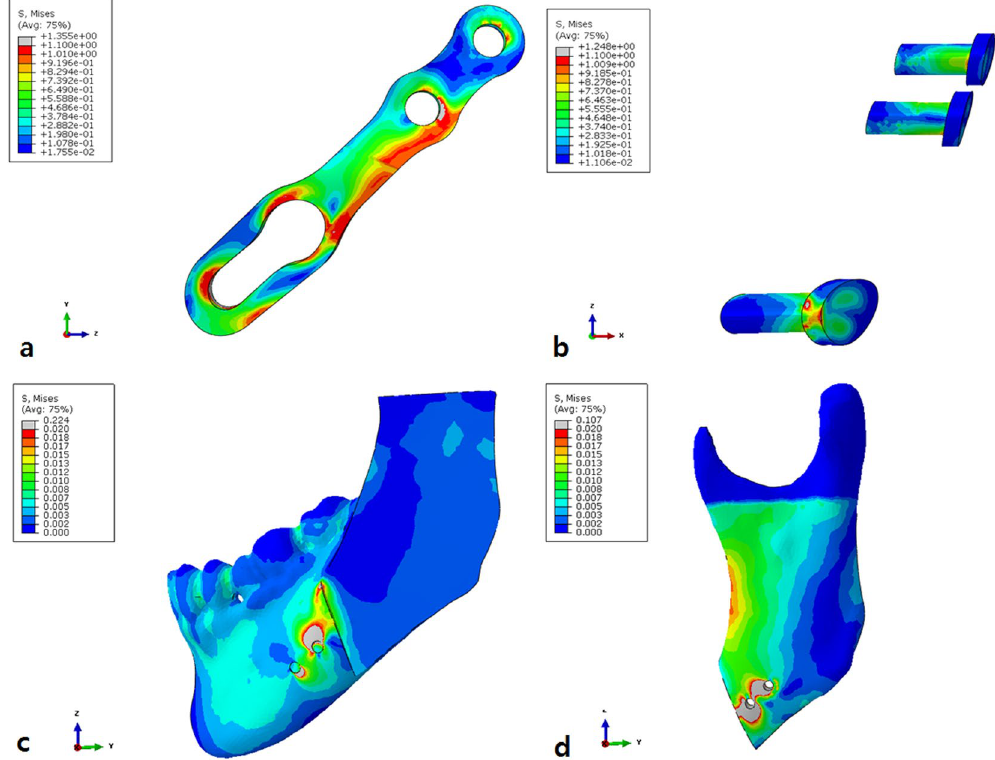
Figure 3. Finite-element model demonstrating stresses in the YK-plate model. ( a ) YK-plate, ( b ) Three screws, ( c ) Distal segment (buccal view) and ( d ) Proximal segment (buccal